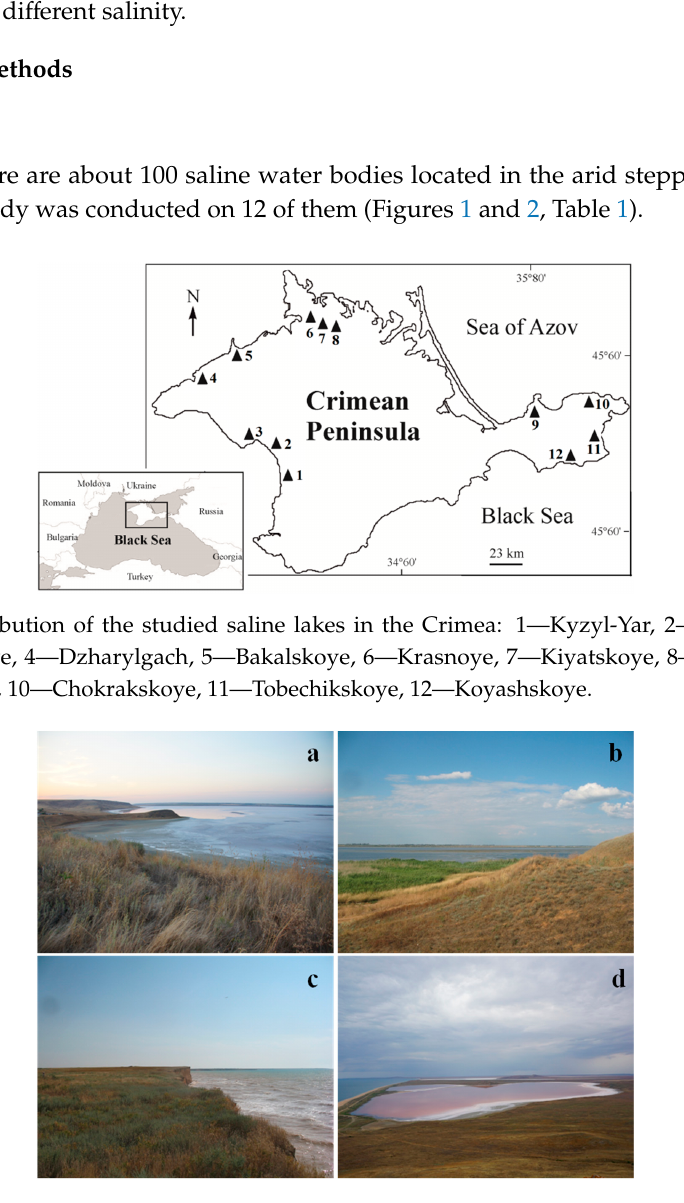
Figure 2. Photoviews of some studied lakes: ( a ) — Lake Tobechikskoye, ( b ) — Lake Kyzyl-Yar, ( c ) — Lake Bakalskoye, ( d ) — Lake Koyashskoye.